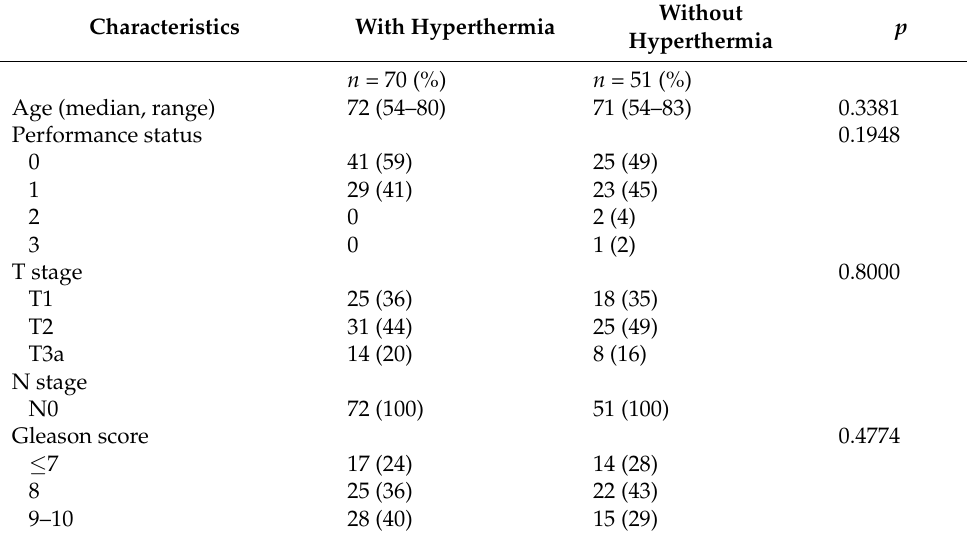
Table 1. Patient